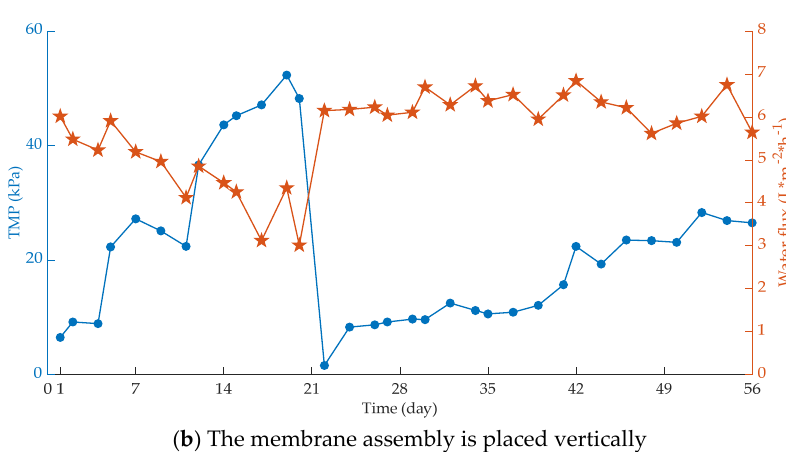
Figure 3. Influence of membrane placement on membrane fouling. ( a ) The membrane assembly is placed horizontally; ( b ) The membrane assembly is placed vertically.